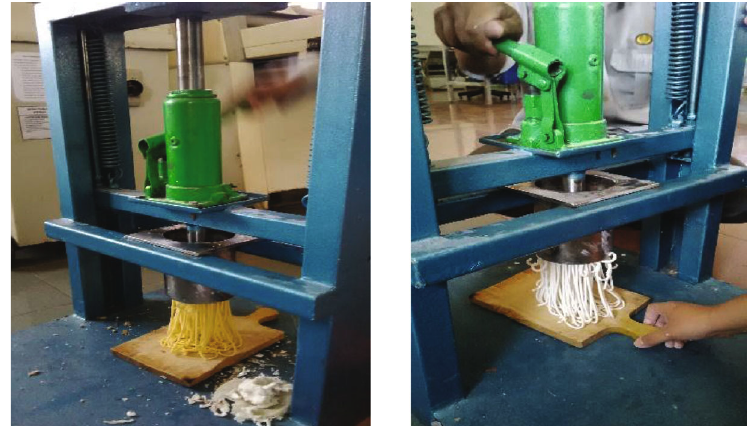
Figure 1: Corn fl our vermicelli (left) and rice fl our vermicelli (right) and a hydraulic press system for wet vermicelli